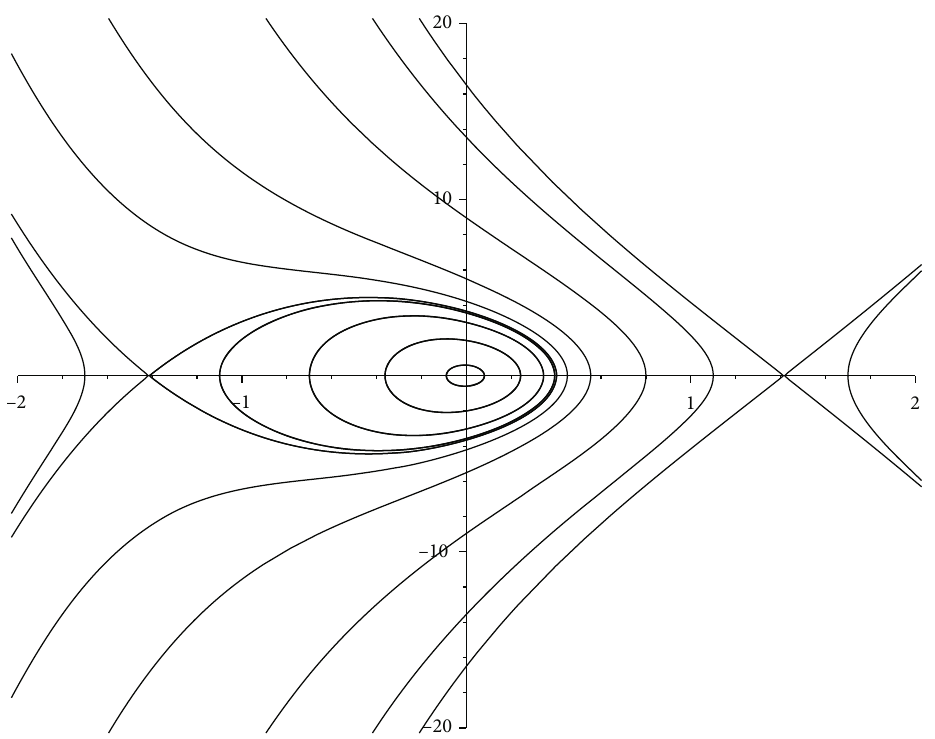
Figure 8: The phase portrait of x ′′ + μ x ′ 2 + ax − bx 3 = 0 , a = 50 , b = 25 , and μ = 1 .